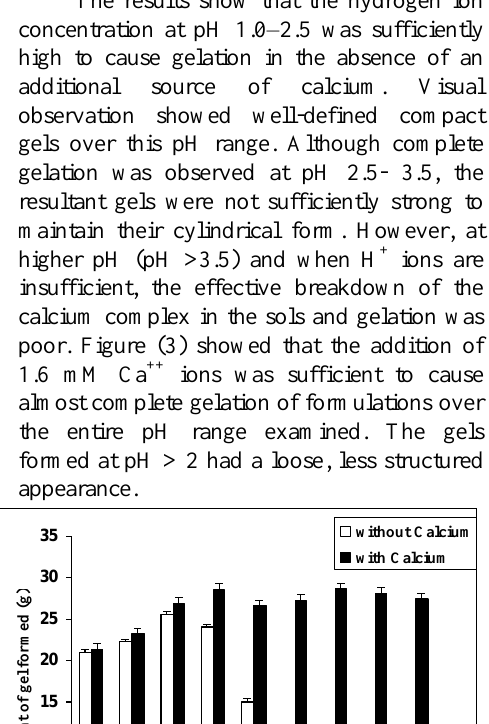
Figure (2): Cumulative % released of naproxen as a function of square root of time from 1% (w/v) concentrations of pectin, sodium alginate and gellan gum gels. Effect of pH and Added Ca ++ Ion on: The gelation: